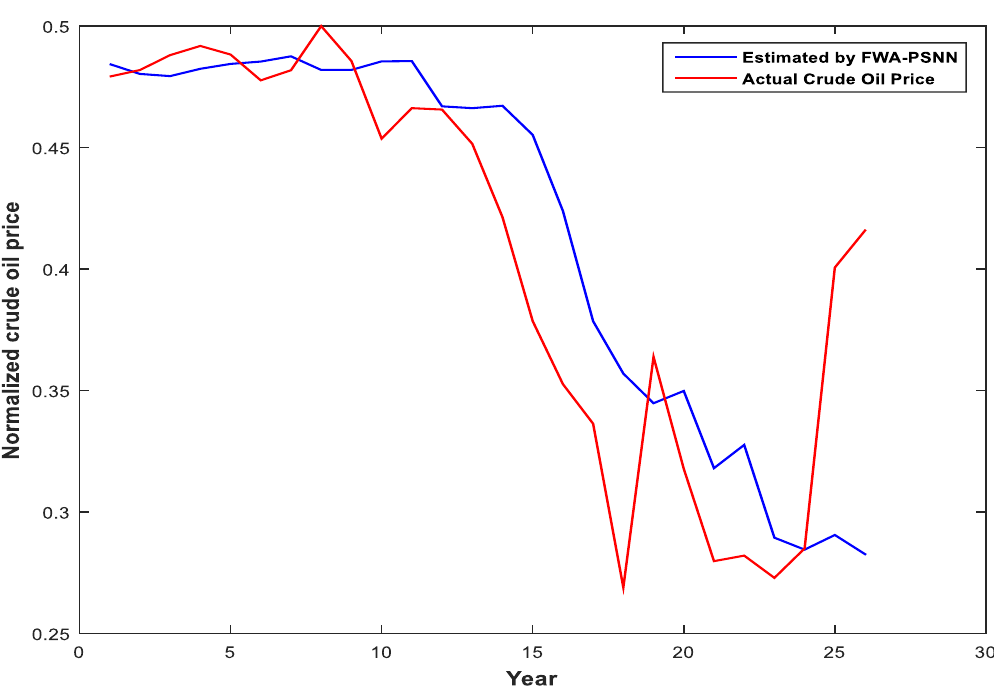
Figure 9. Actual crude oil prices v/s estimated by FWA-PSNN from annual crude oil price time series